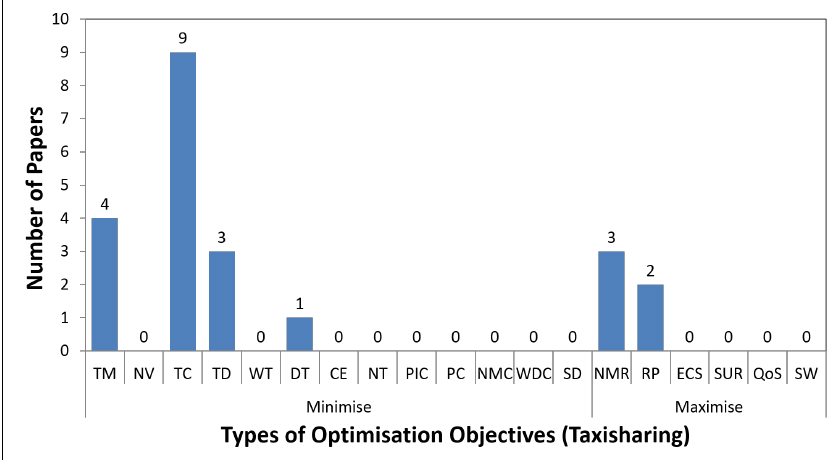
Figure 14. Distribution of Papers based on the Optimisation Objectives: